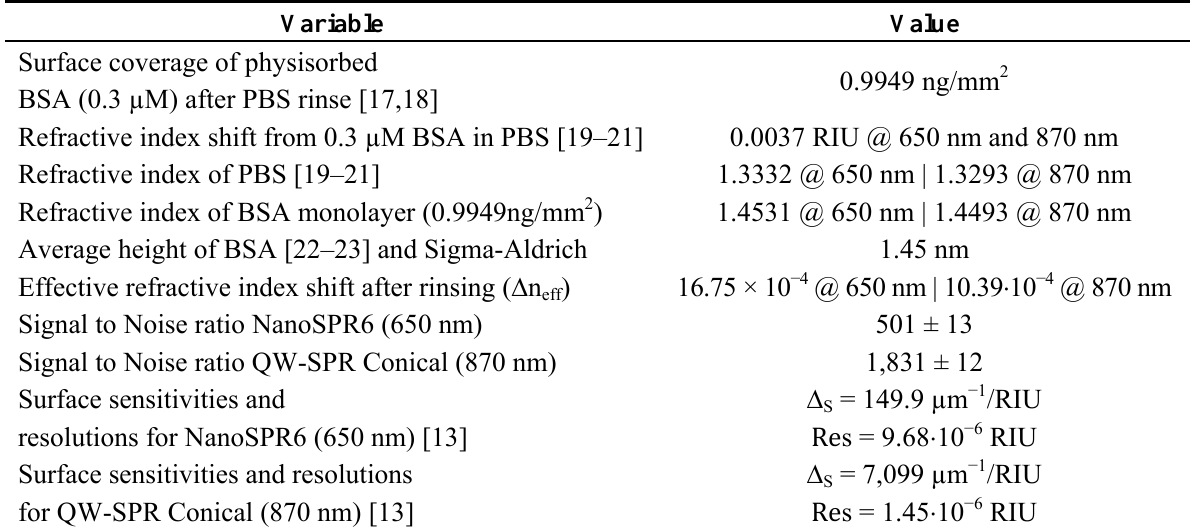
Table 1. Summary of refractive indices and